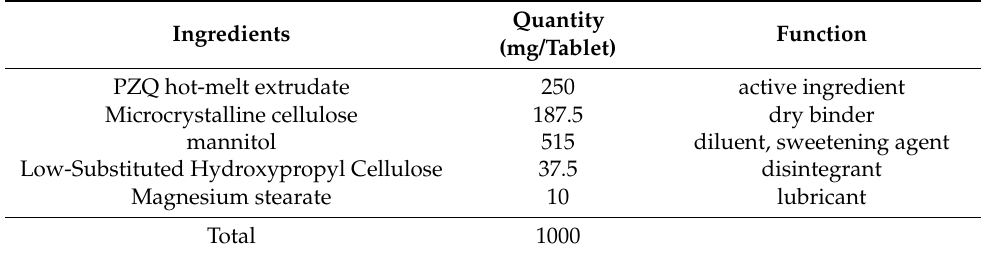
Table 1. Composition of orally disintegrating/sustained-release praziquantel tablets. Quantity Ingredients